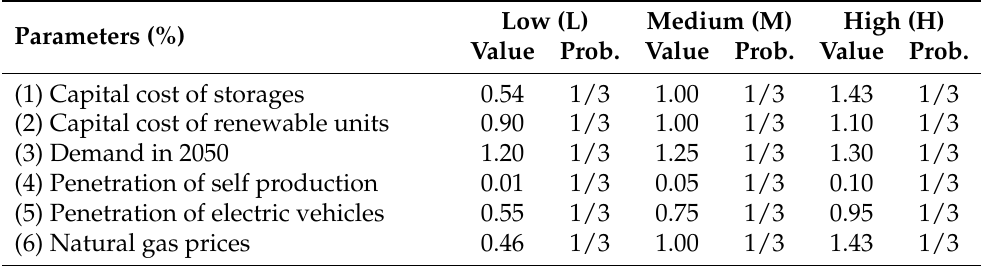
Table 9. Parameters modeled through scenarios (per